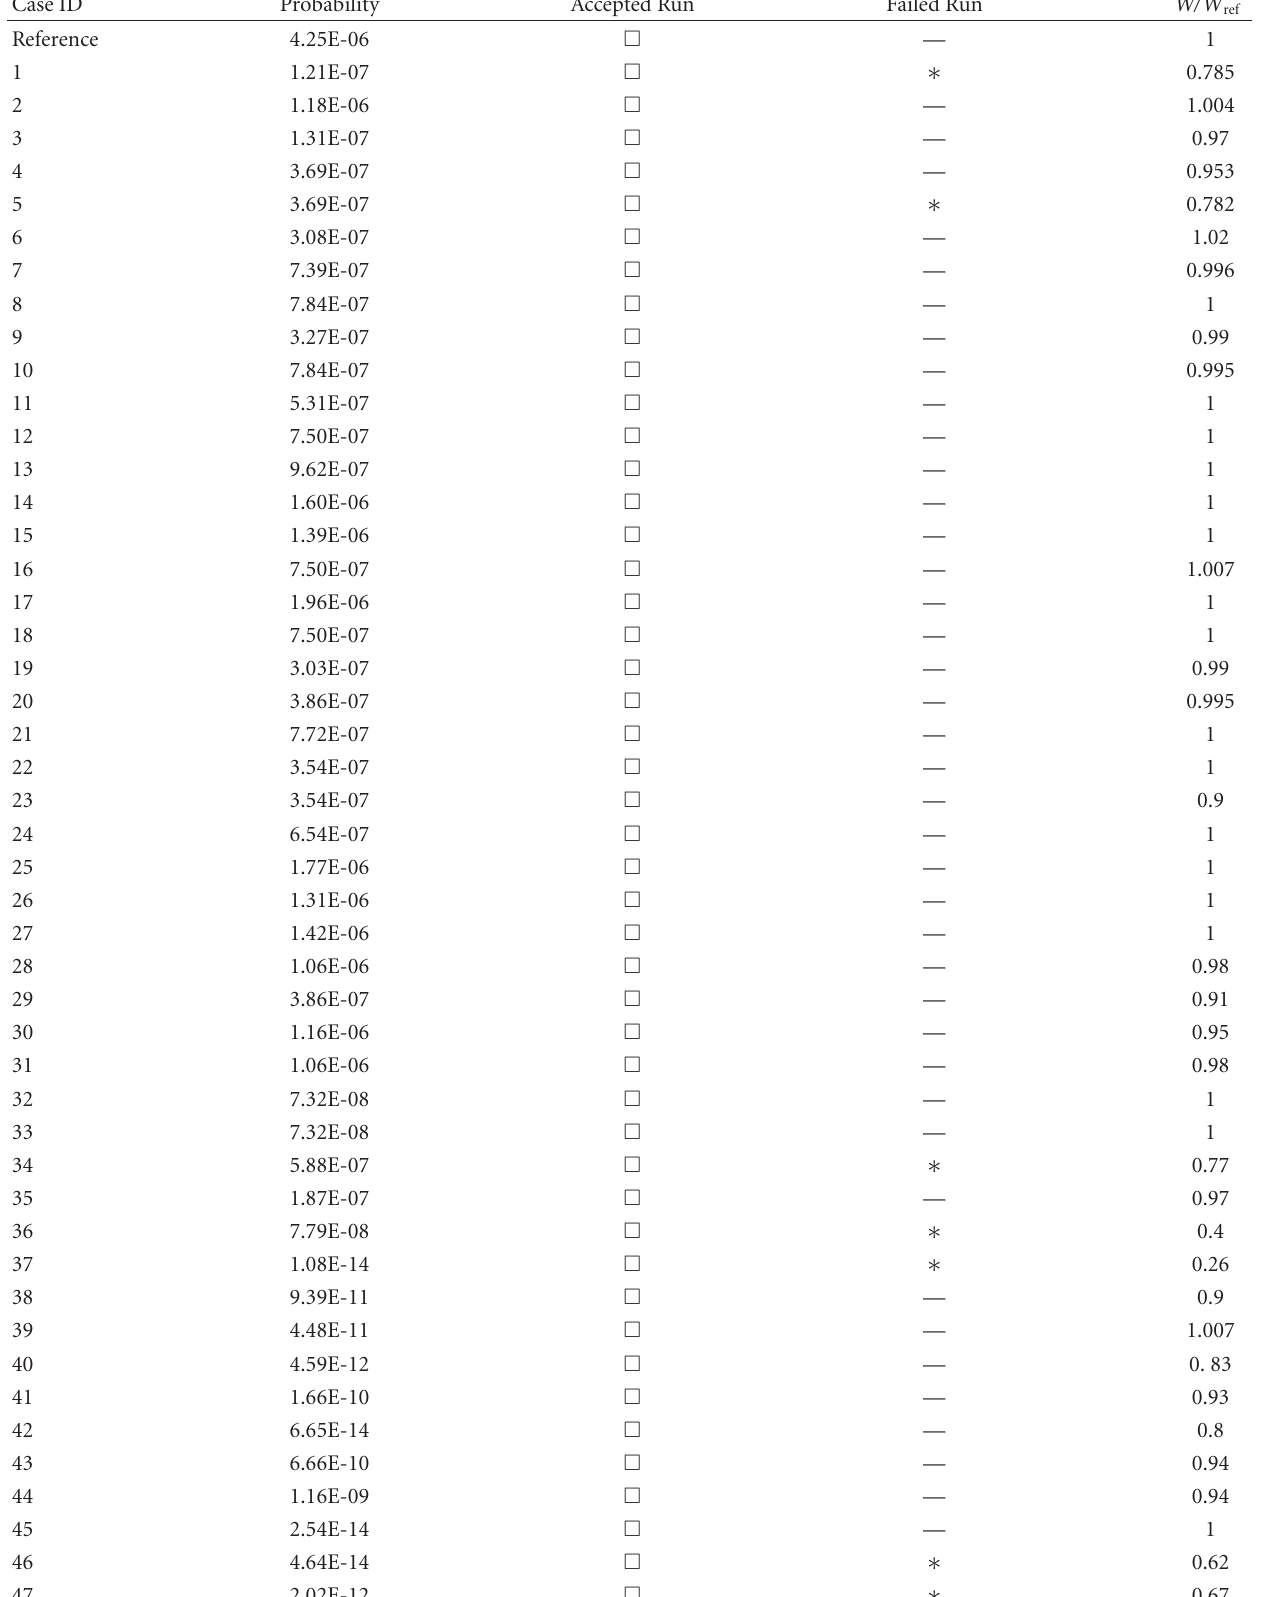
Table 6: Selected system performance indicator related to individual probability